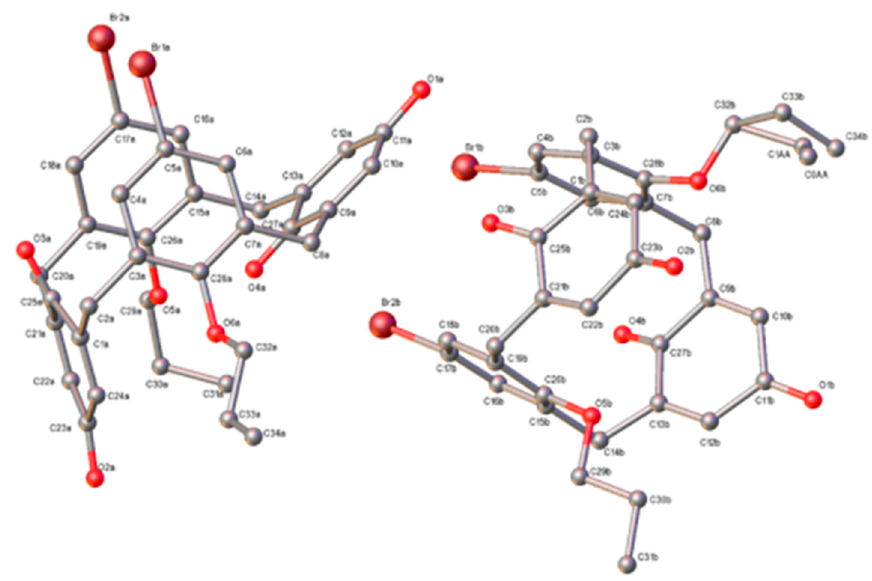
Figure 3. Asymmetric unit found in the single crystal X-ray structure of 1 . Hydrogen atoms have been omitted for clarity. One lower-rim propoxy group is disordered over two positions and has been successfully modelled at partial occupancies.